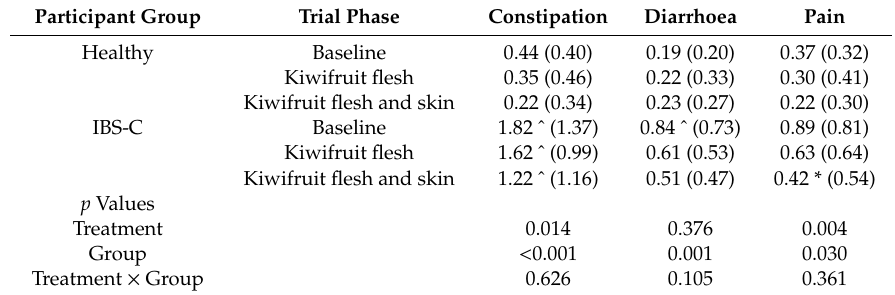
Table 6. Gastrointestinal discomfort measured by Birmingham IBS questionnaire for the